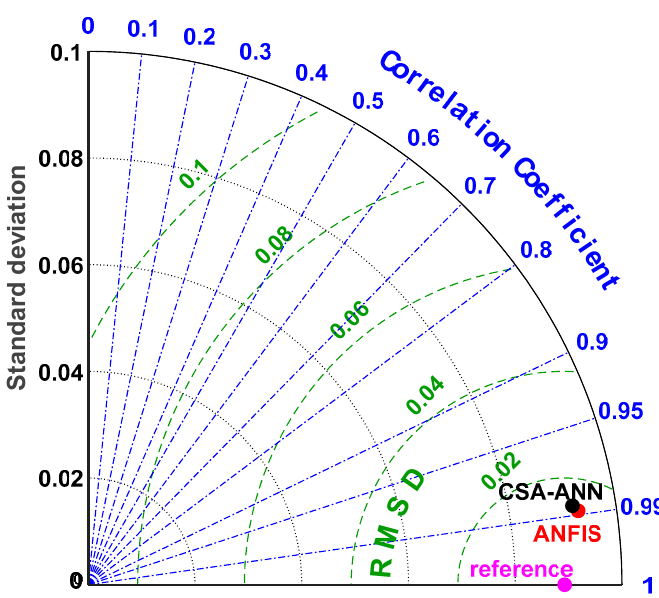
Figure 8. Taylor diagram for ANFIS and CSA-ANN prediction models.